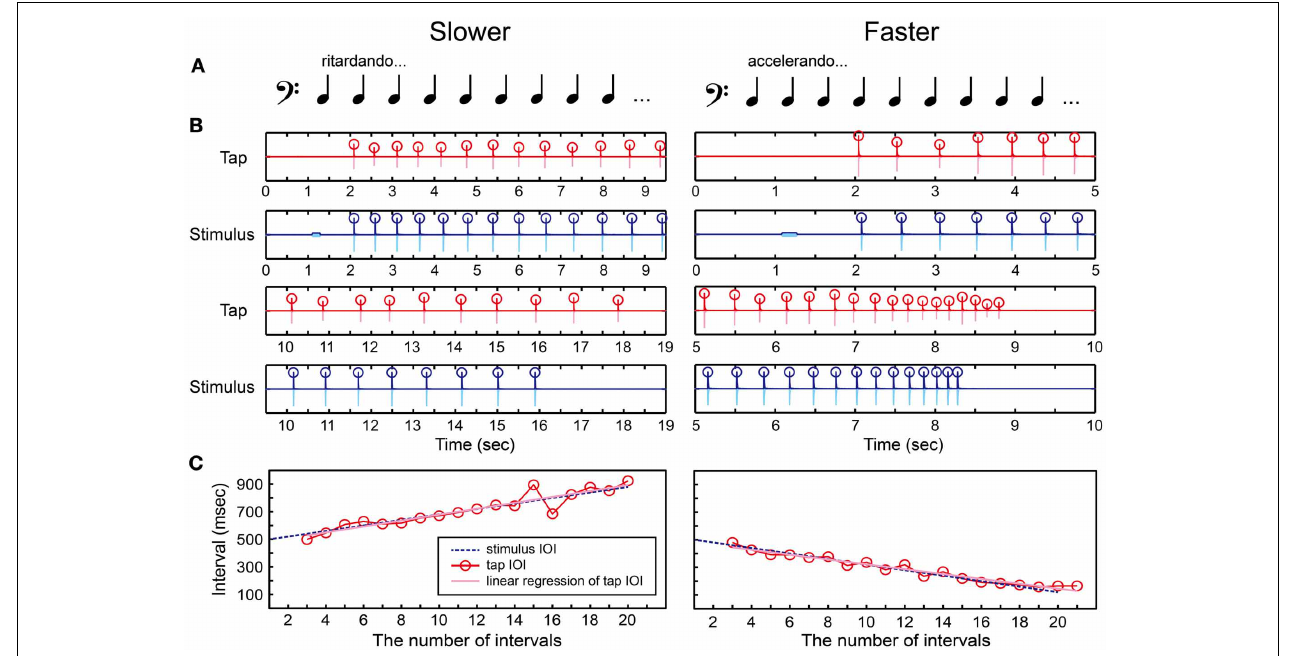
FIGURE 6 | Beat interval test (BIT). (A) Two temporal-change patterns [slowing down (ritardando, slower) or speeding up (accelerando, faster)] were created by changing inter-stimulus interval (ISI) between woodblock tones. (B) An example of recorded tap signal (pink), its envelope (red), recorded auditory stimulus (light blue), and its envelope (blue). Circles represent the